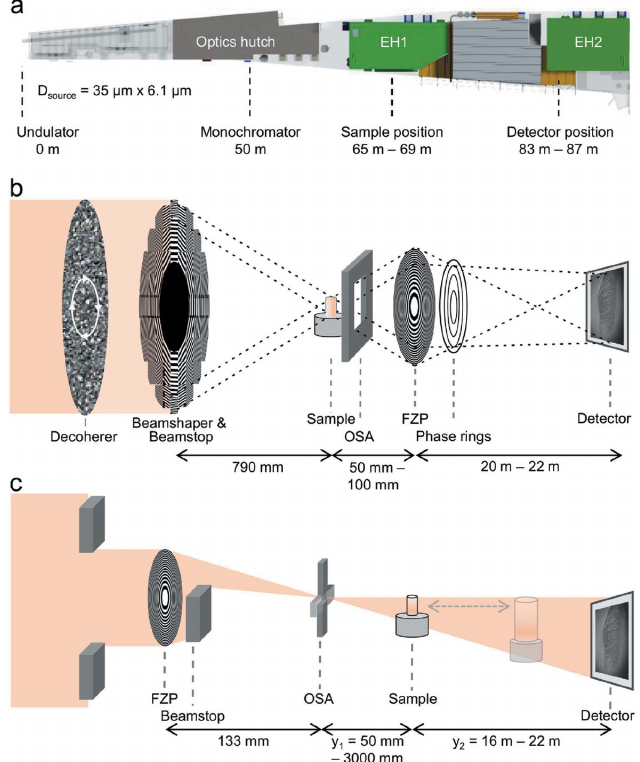
Figure 1 ( a ) Overview of the beamline P05 with relevant hardware components and their distances to the source. The nanotomography setup is located in the first experimental hutch (EH1) while the camera is placed in the second experimental hutch (EH2). ( b ) Zernike phase contrast imple- mented in a standard transmission X-ray microscope and ( c ) near-field holography setup using a Fresnel zone plate (FZP) as focusing optics. This setup was also used for the near-field pytchography 12 individual chips of 256 (cid:2) 256 pixels, arranged on a 2 (cid:2) 6 grid. At the edges between adjacent chips there are larger pixels of size 55 m m (cid:2) 165 m m (edges) and 165 m m (cid:2) 165 m m